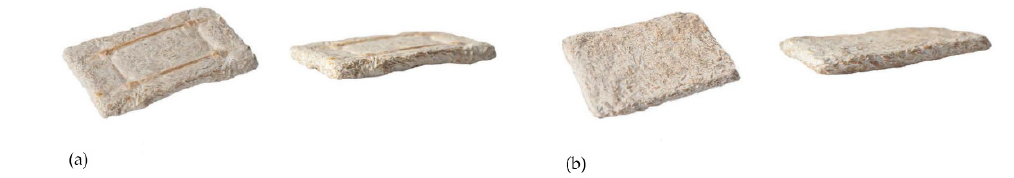
Figure 7. ( a ) Results of multilayer composite, ( b ) hemp mat